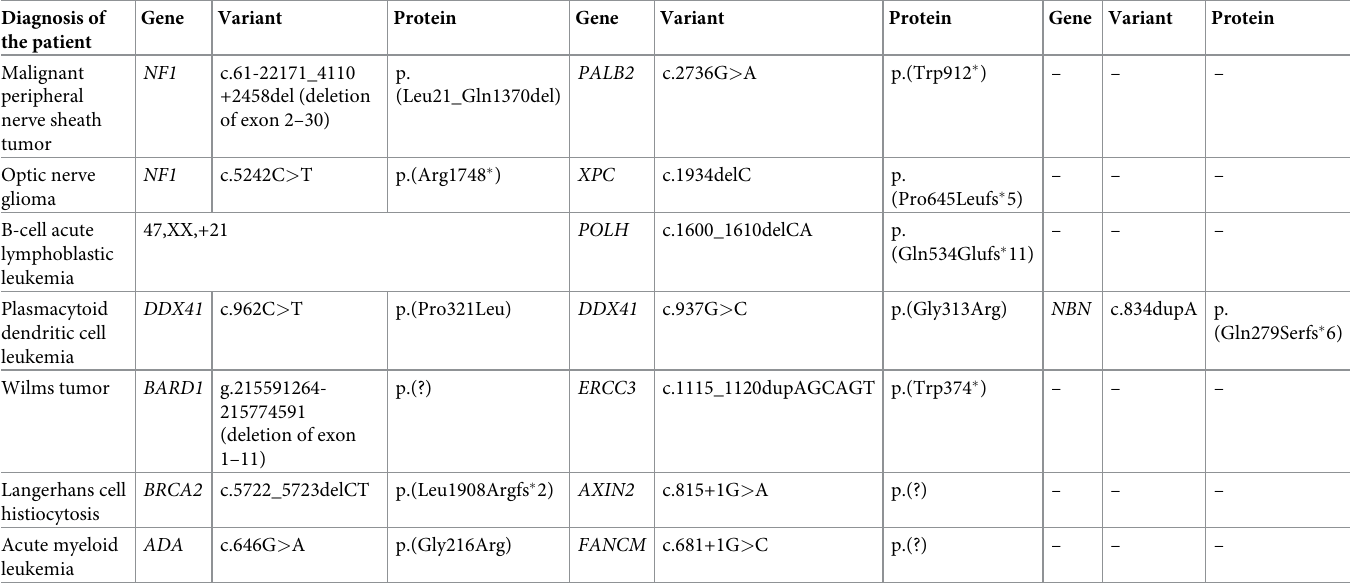
Table 7. Patients carrying more than one pathogenic/likely pathogenic